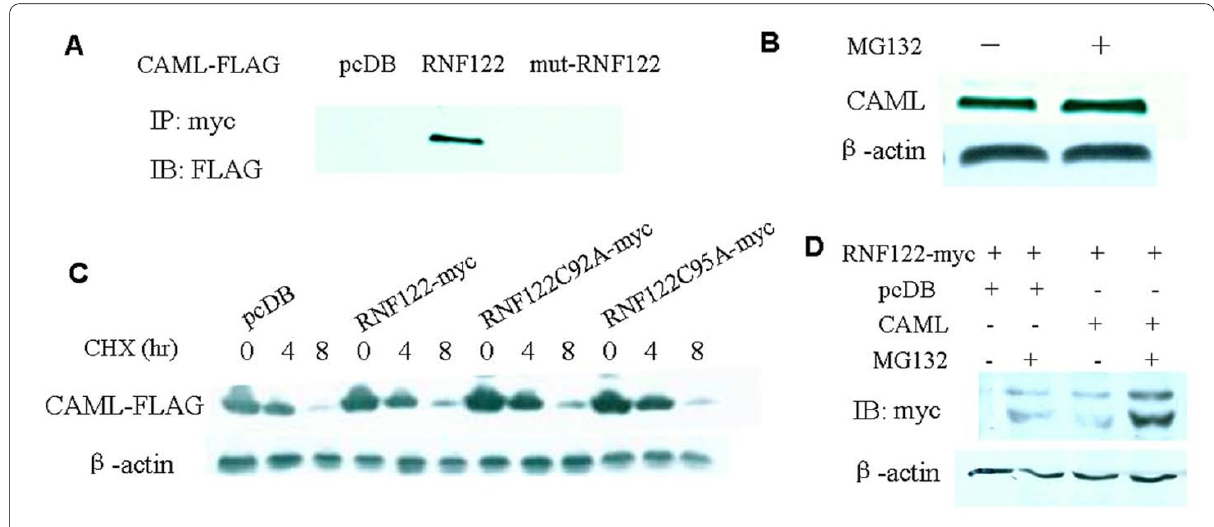
Figure 3 Interaction of RNF122 with CAML . (A) In mammalian cells, RNF122 interacted with CAML. HEK293T cells were seeded into 60-mm plates and transfected with pcDB (empty), RNF122-myc or mut-RNF122-myc vectors in conjunction with CAML-FLAG. After 48 h, the cells were treated with 2.5 μg/mL MG132 for 6 h, lysed in PBS containing 1% Triton X-100, and immunoprecipitated with anti-myc antibody agarose beads. (B) CAML is not involved in the proteasome-dependent degradation pathway. HEK293T cells were treated with 2.5 μM MG132 or vehicle (DMSO) for 6 h. The